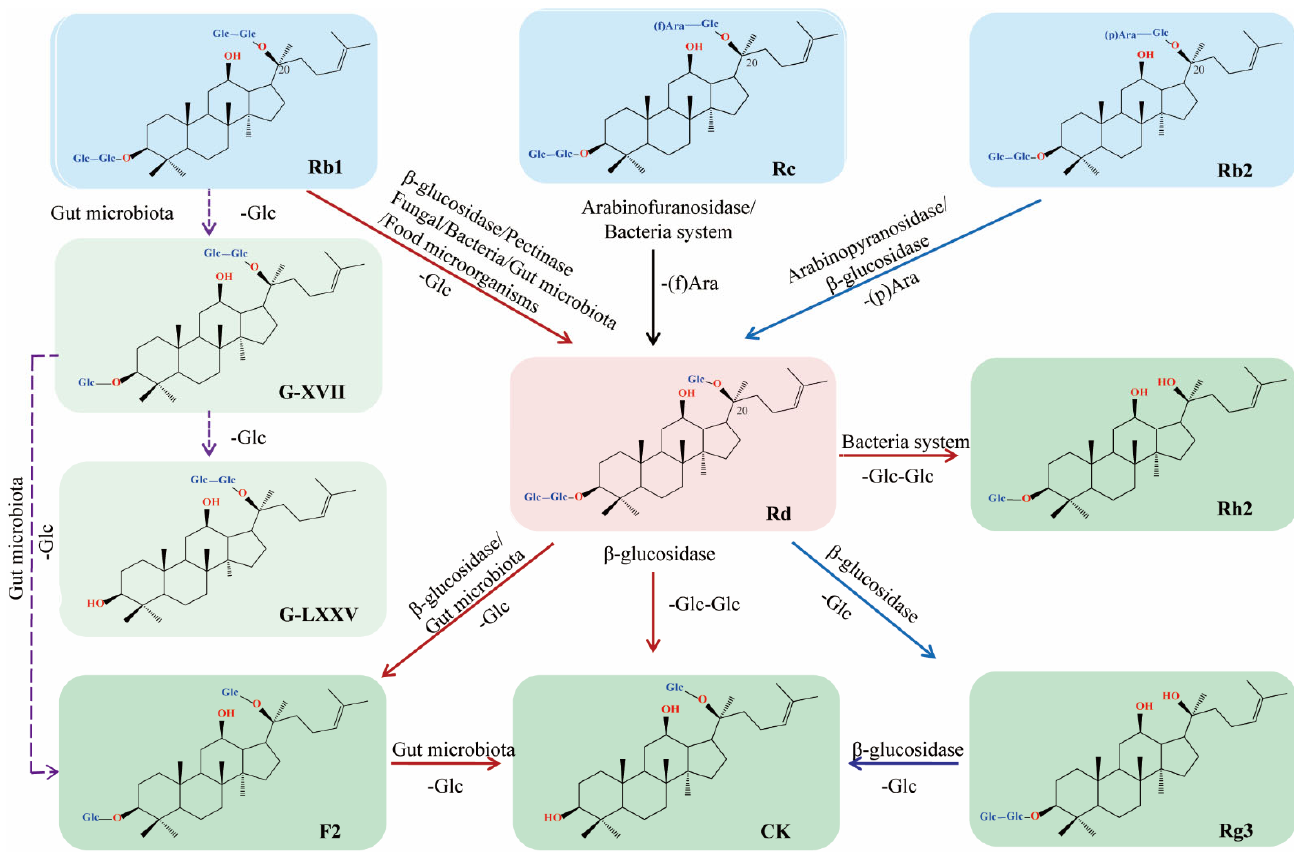
Figure 1. Schematic illustration of biotransformation of major ginsenosides Rb1, Rb2, and Rc to Rd ( ⟶ major pathway; ⤏ minor pathway).